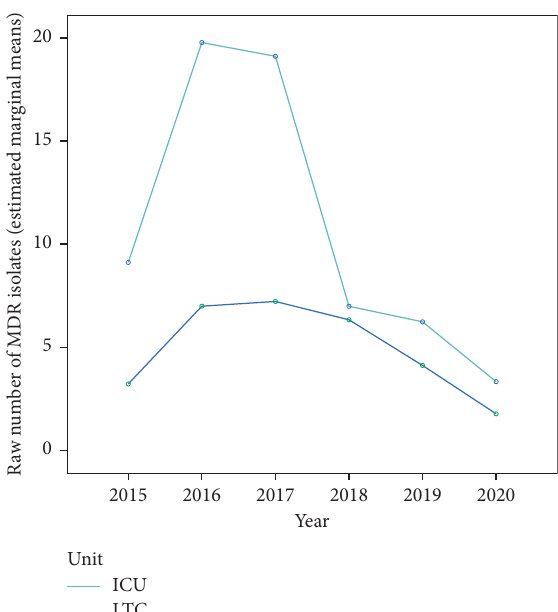
Figure 6: Estimated marginal means of the number of isolated multidrug-resistant (MDR) organisms in hospital-acquired infections, in intensive care (ICU) and long-term care (LTC) units, during the five years following the implementation of the antimicrobial stewardship